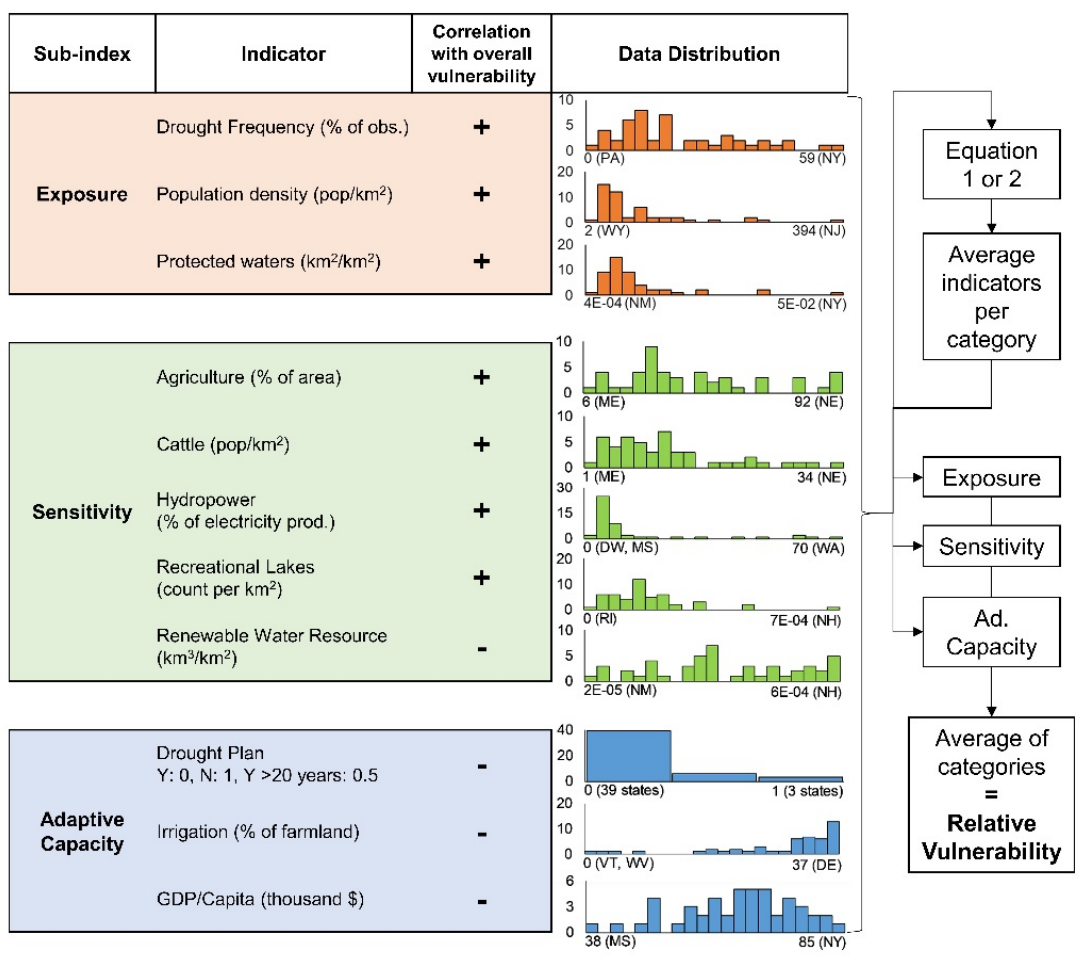
Figure 1. The indicators used in the analysis, grouped into their respective sub-indices, Exposure, Sensitivity, and Adaptive Capacity. The correlation sign with the overall relative vulnerability is also noted. The distribution of the indicator data is shown in color-coded histograms, with the y-axis representing the number of states in each bin. The histograms also show the min and max value for each indicator and from what state the extreme values originate. The indicator data are then entered